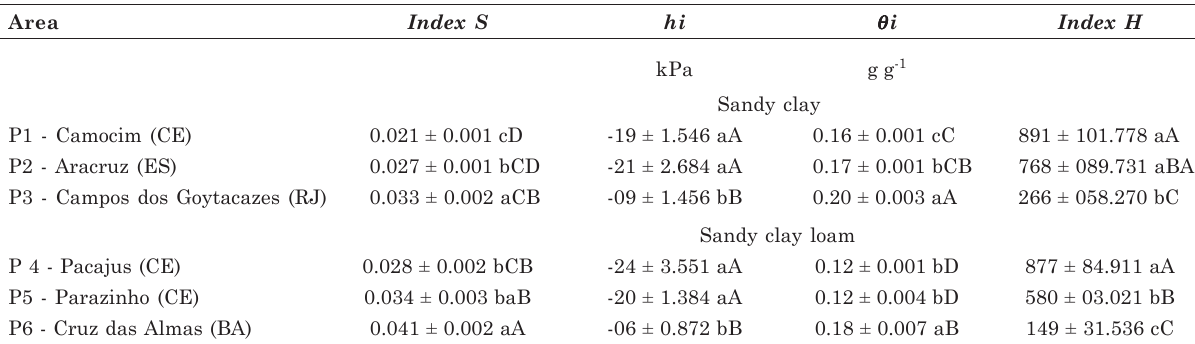
Table 4. Mean and standard error of Index S , optimal water potential for tillage ( hi ), optimal soil water content for tillage ( θθθθθ i ) and hardsetting index ( H ) for the hard-setting soils studied (n=3)